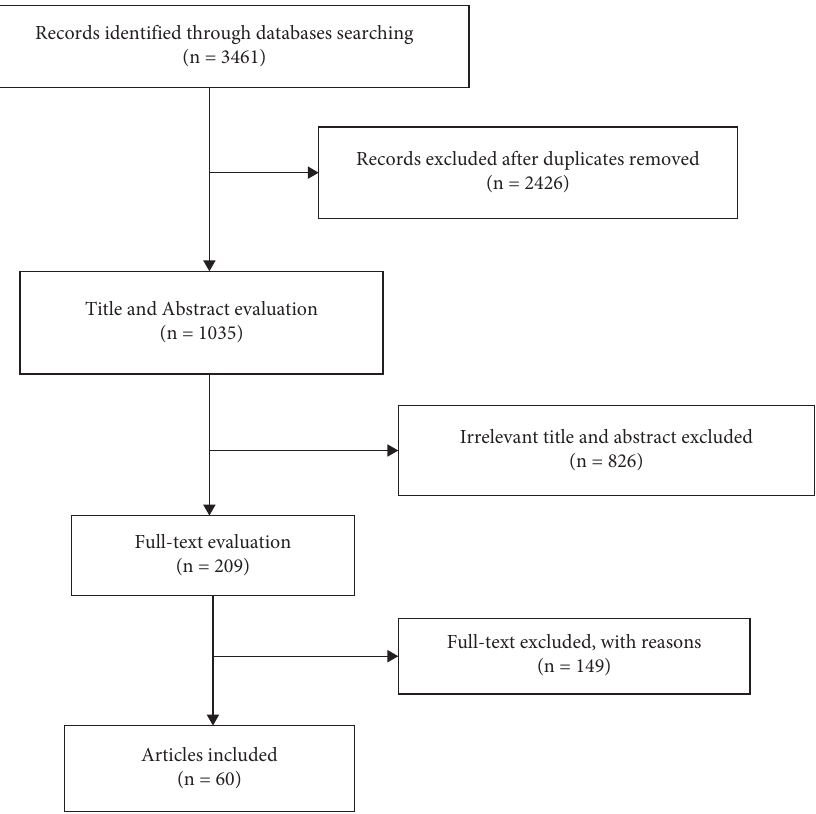
Figure 1: PRISMA 2009 flow diagram and summary of the literature search and study